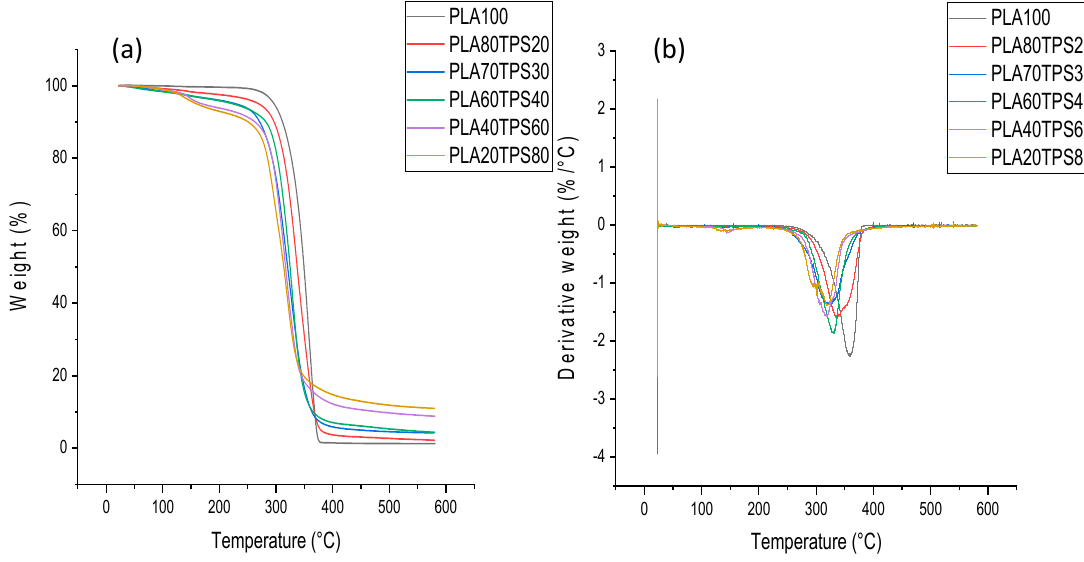
Figure 9. (a) Thermogravimetric analysis (TGA), (b) derivative thermogravimetric (DTG) curves of PLA100 and PLA/TPS blend bionanocomposites. Table 3. Thermal degradation temperature of PLA100 and PLA/TPS blend bionanocomposites. Sample